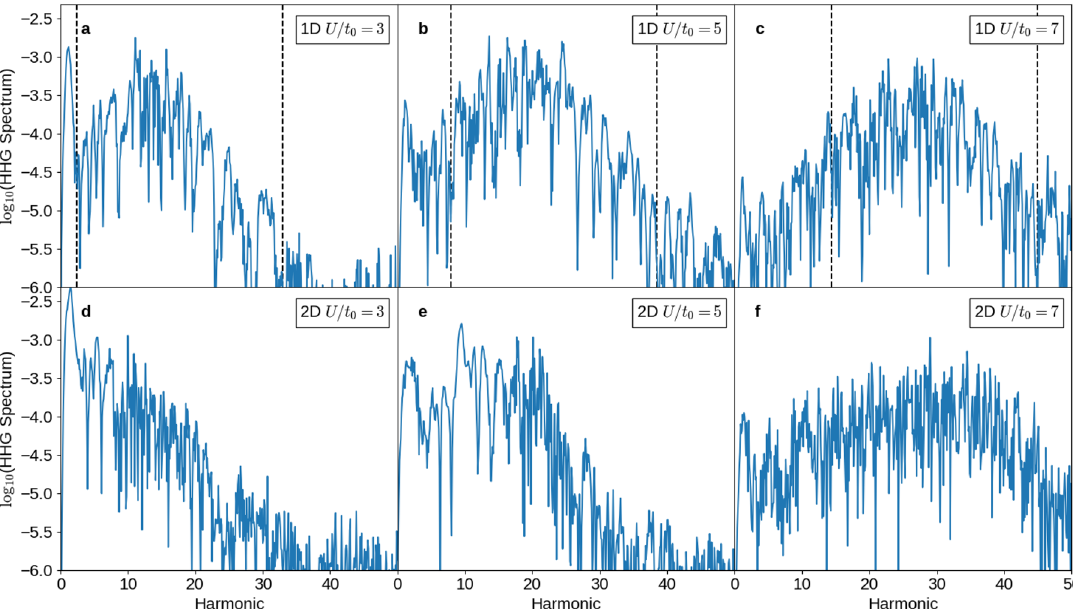
Fig. 2 Time-averaged spectrum against emitted high-harmonic order. HHG in 1D ( a – c ) and 2D ( d – f ), for interaction strengths U / t 0 = 3, 5, 7, calculated by tVMC. The dashed lines in the 1D plots show the energy range Δ to Δ + 8 t 0 .